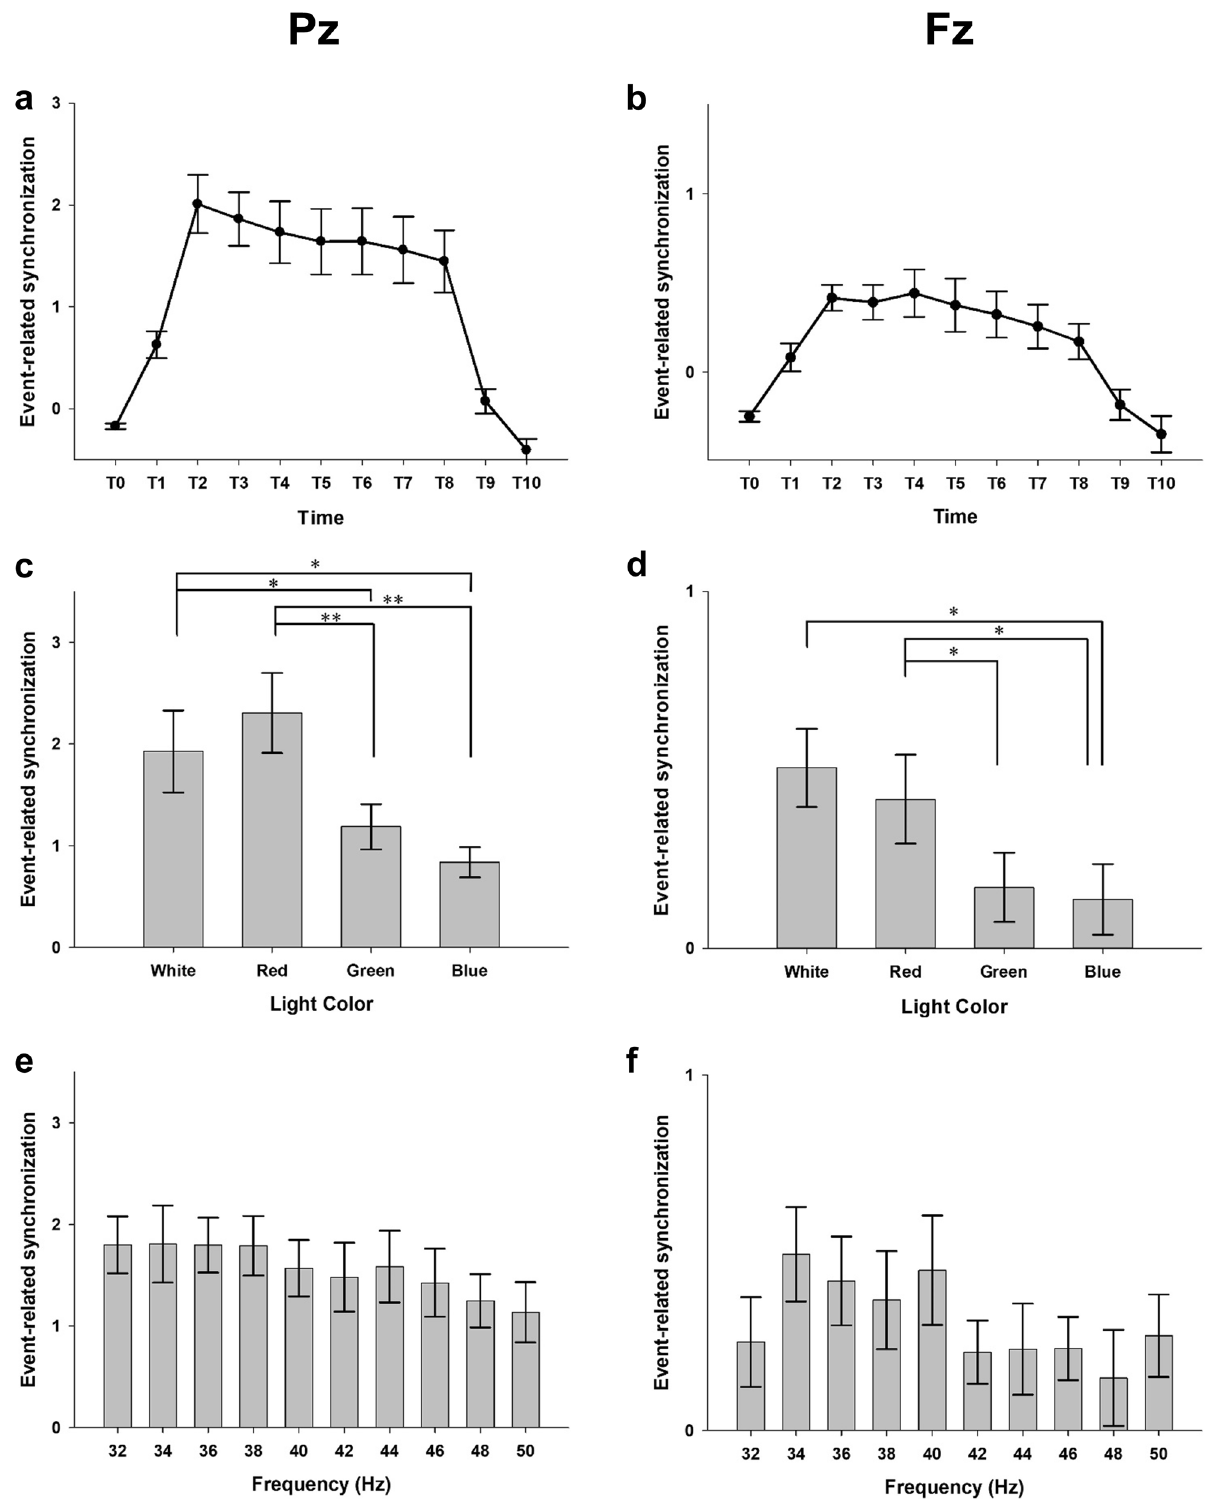
Figure 2. Plots of results of the repeated measures ANOVA in the EXP-1. Averaged event-related synchronization of steady-state visually evoked potentials induced by flickering light stimulus (FLS) in the first experiment. T0–T10 indicates 250 ms time windows from 250 ms before the onset of FLS to 500 ms after the offset of FLS. The main effect of the time window on ERS at Pz ( A ) and Fz ( B ). The main effects of the color of FLS on ERS at Pz ( C ) and Fz ( D ). The main effect of flickering frequency of FLS on ERS at Pz ( E ) and Fz ( F ). Error bars indicate standard errors. * p < 0.05, ** p < 0.01, *** p < 0.001, by repeated measures analysis of